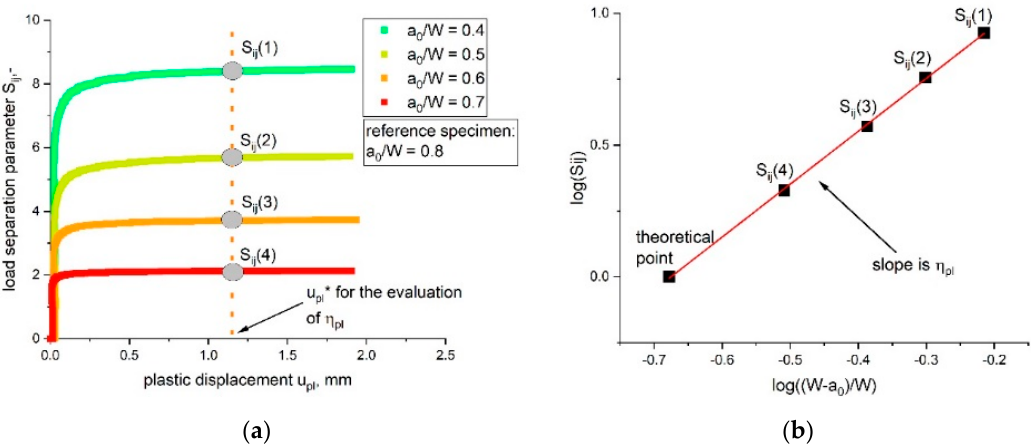
Figure 1. ( a ) Determined load separation curves (S ij as function of u pl ) of bN specimens with a changing a 0 /W ratio and the chosen limit value u pl *. ( b ) Evaluation of η pl as the slope of the S ij over the (W − a 0 )/W plot.